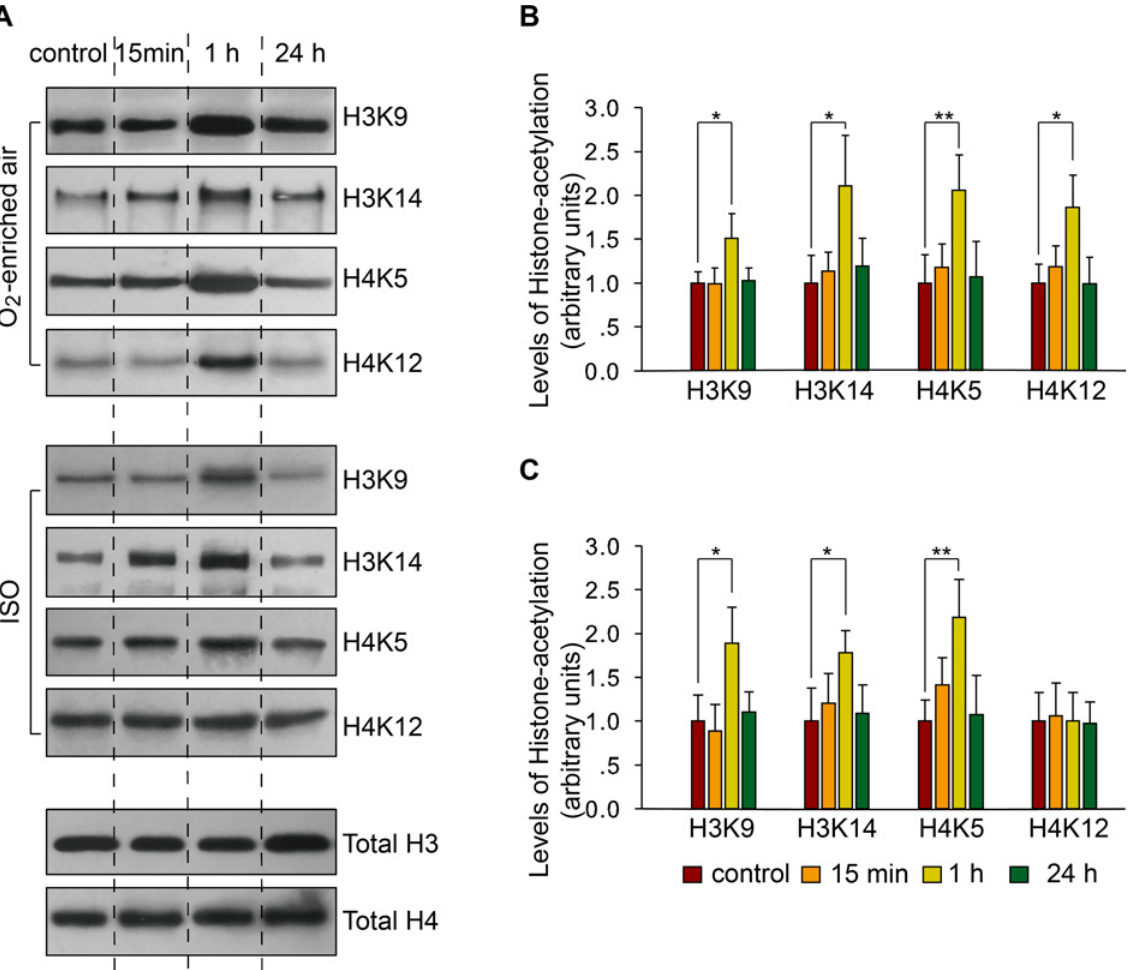
Fig 2. Repeated neonatal exposures to isoflurane induce H4K12 acetylation dysregulation in the CA1 hippocampal region in response to CFC training. (A) Representative images of western blots showing histone acetylation levels in the CA1 hippocampal region at 15 min,1 h, and 24 h after CFC training. Control mice were not subjected to CFC. (B) Quantification of the immunoblots from mice that received repeated exposure to 30% O 2 -enriched air. * p < 0.05 and ** p < 0.01 versus control. (C) Quantification of the immunoblots in mice that received repeated neonatal exposure to isoflurane. * p < 0.05 and ** p < 0.01 versus control. Mean (SD) values are shown.